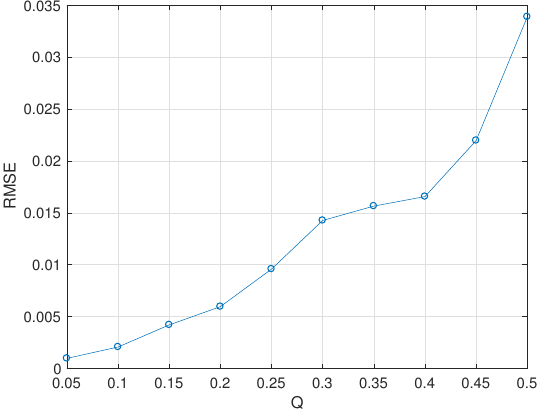
Figure 14. RMSE of the estimated output of the wave